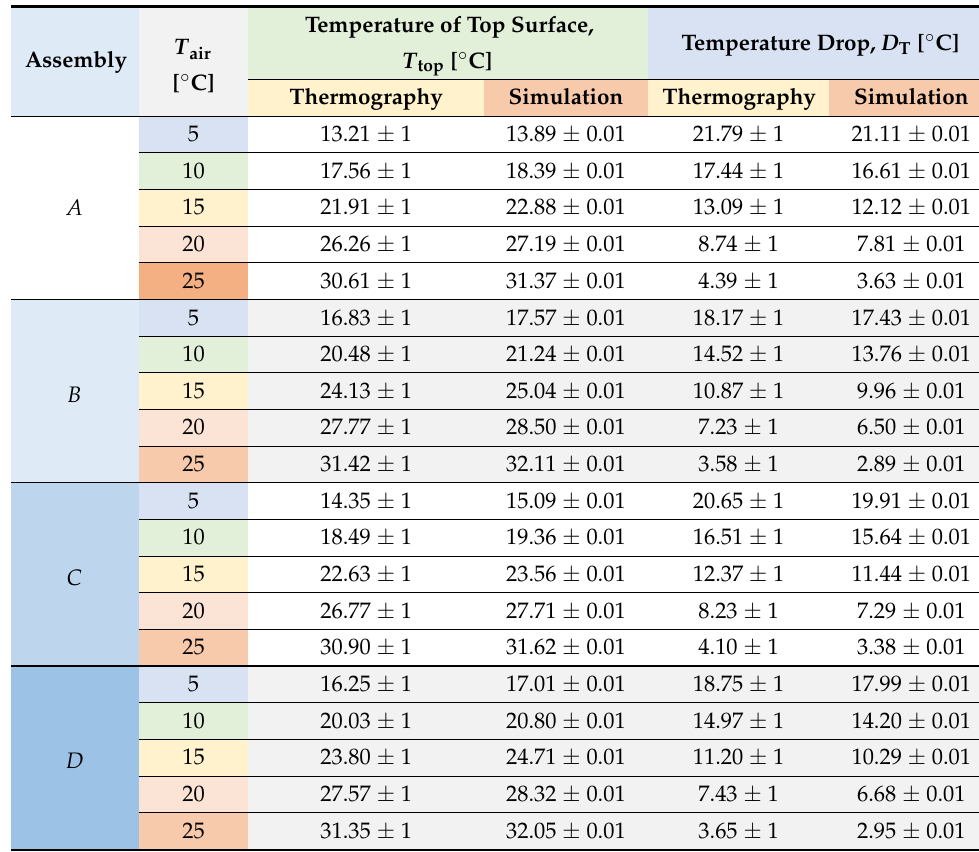
Table 4. Experimental and simulated temperatures of top assembly surface T top and temperature drops D T .